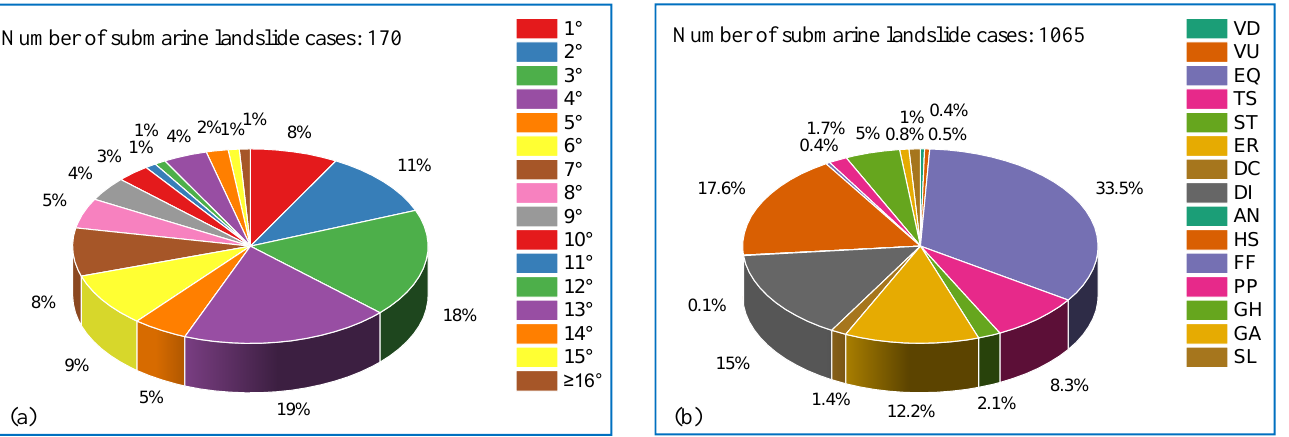
Figure 2. Characteristics of submarine landslides. ( a ) Slope angles of submarine landslides; ( b ) Trigger factors of submarine landslides.